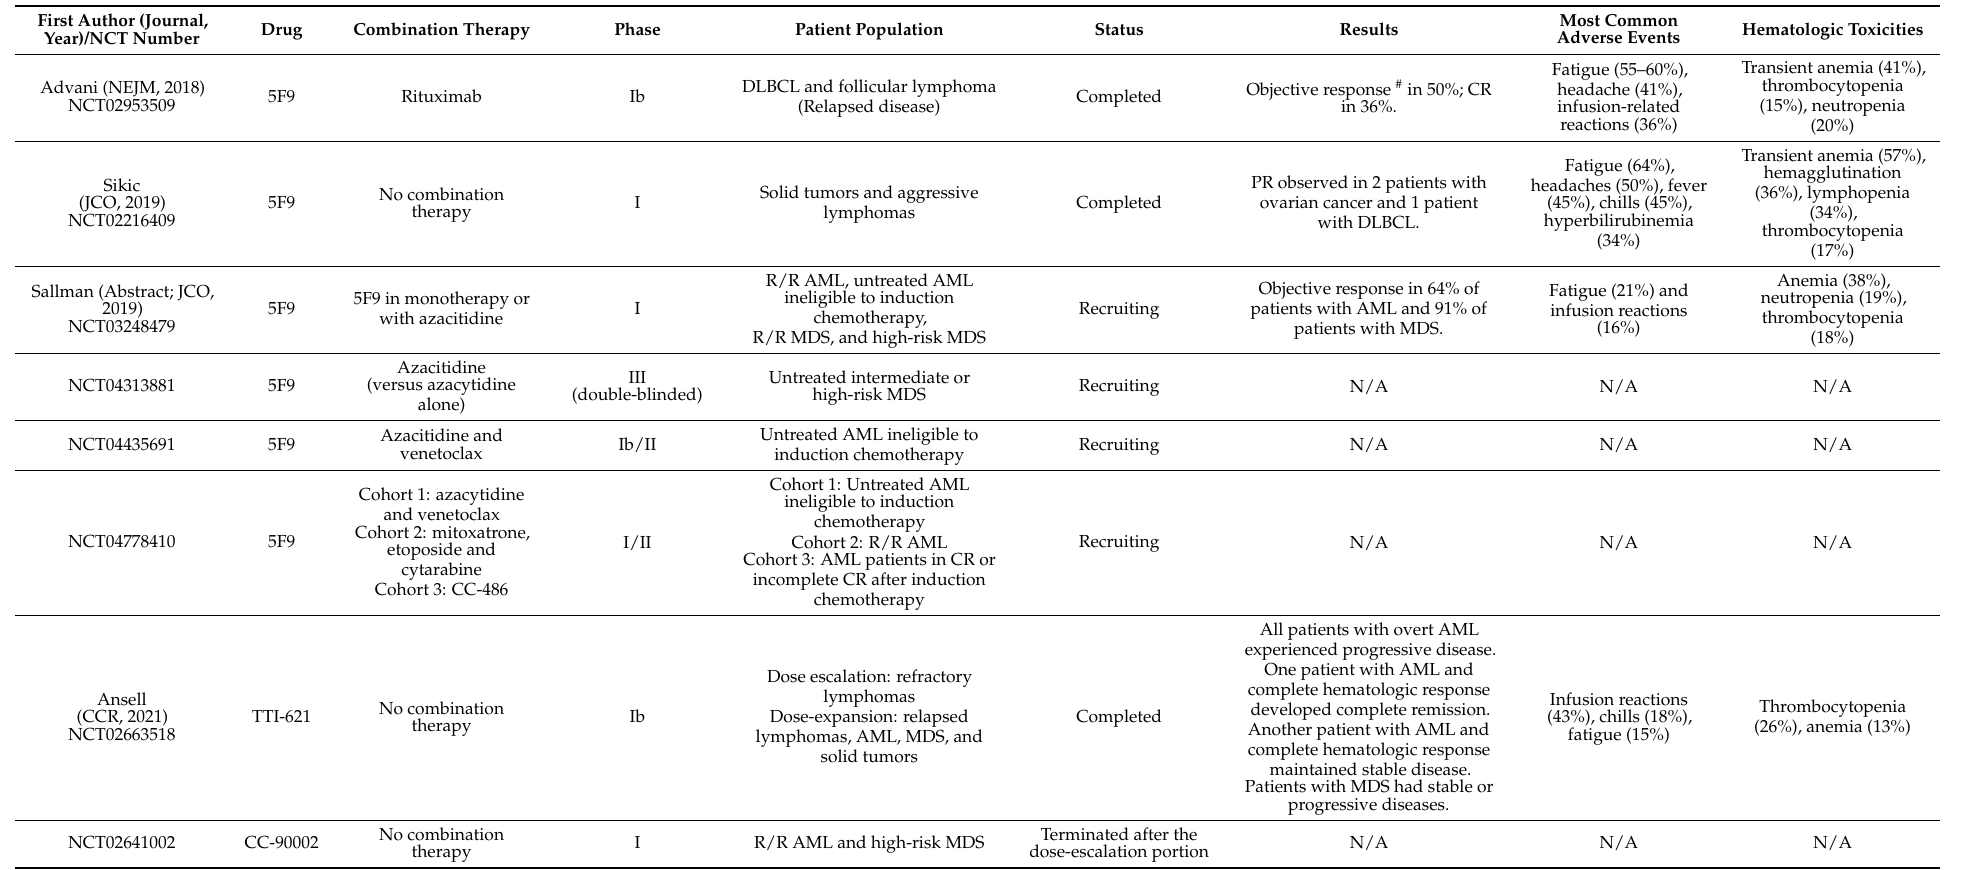
Table 1. Overview of the clinical studies using CD47 blocking agents for the treatment of hematologic